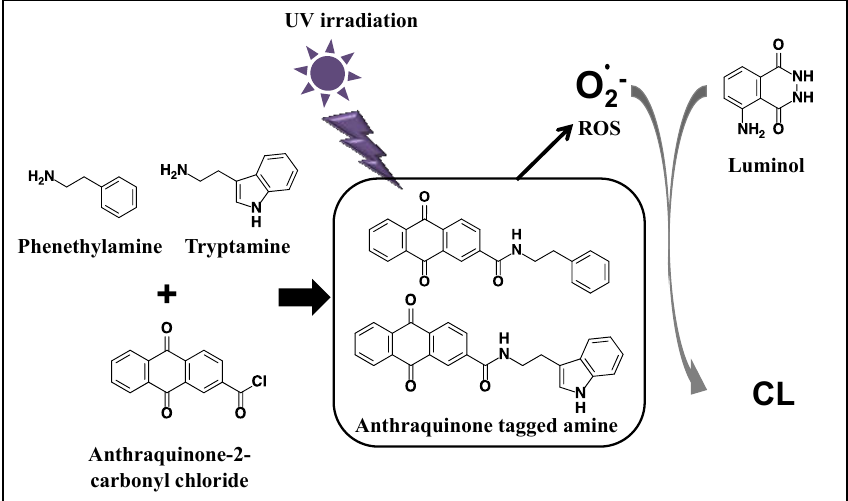
Figure 1. Derivatization of tryptamine and phenethylamine with anthraquinone-2-carbonyl chloride and luminol CL reaction after UV irradiation.